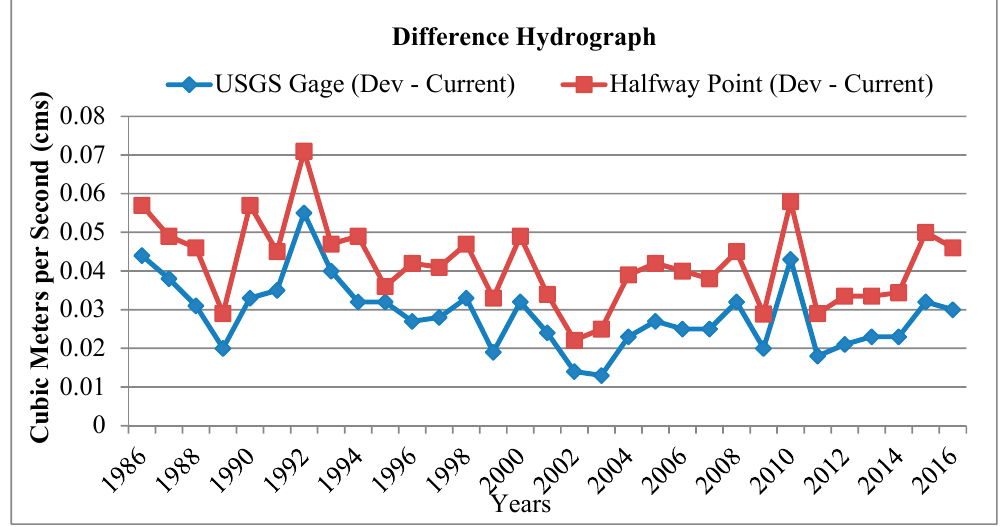
Figure 6. Difference in discharge between Current and Developed scenarios, at Watershed Halfway Point and USGS Gaging Station, from uncalibrated SWAT model iterations.